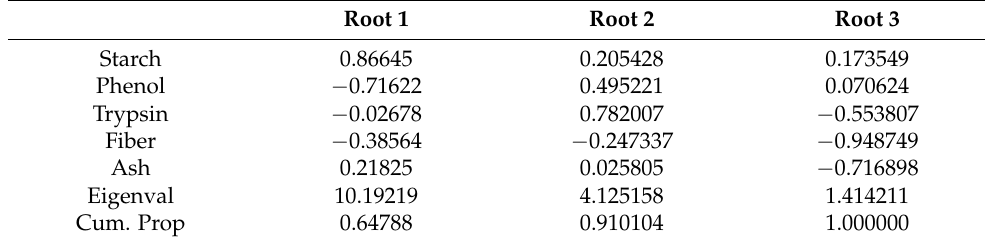
Table 6. Standardized coefficients for canonical